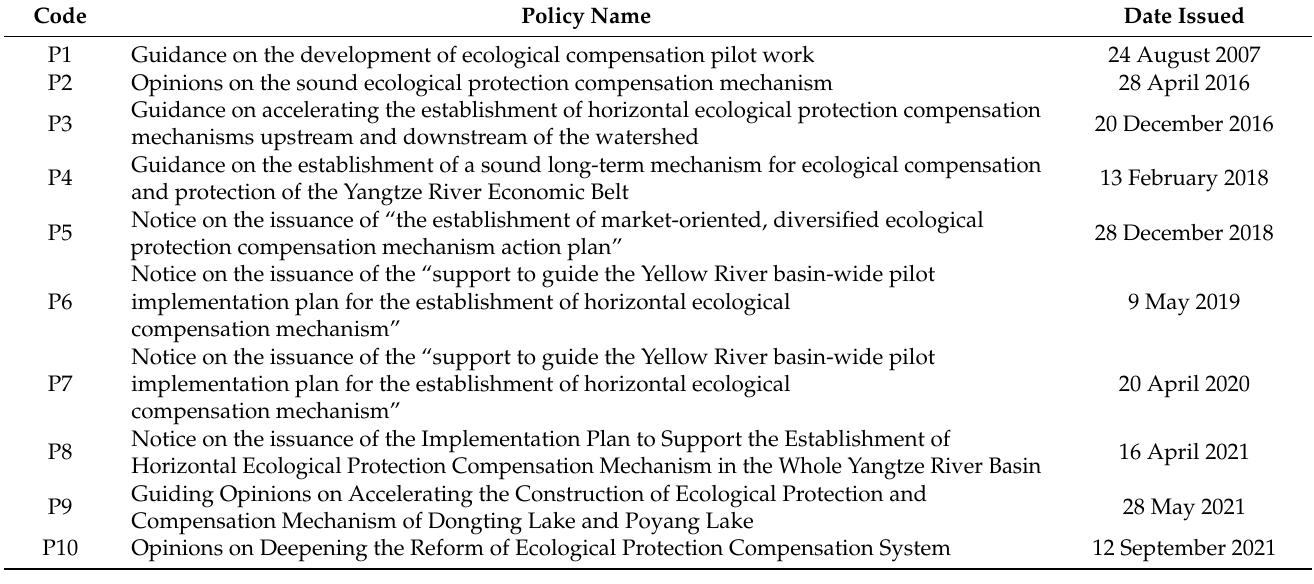
Table 1. Sample policies for PMC index model.